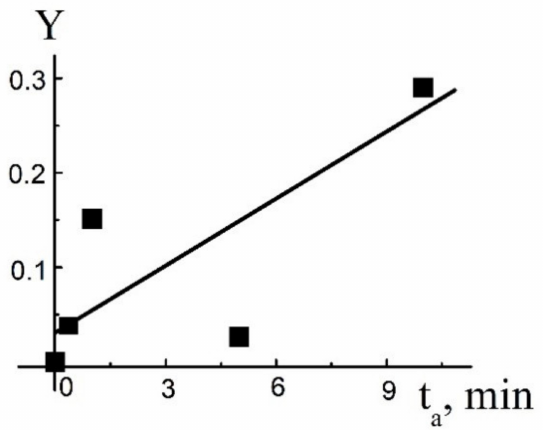
Figure 3. Processing of experimental data using the least-squares method for m ∑ ,0 =